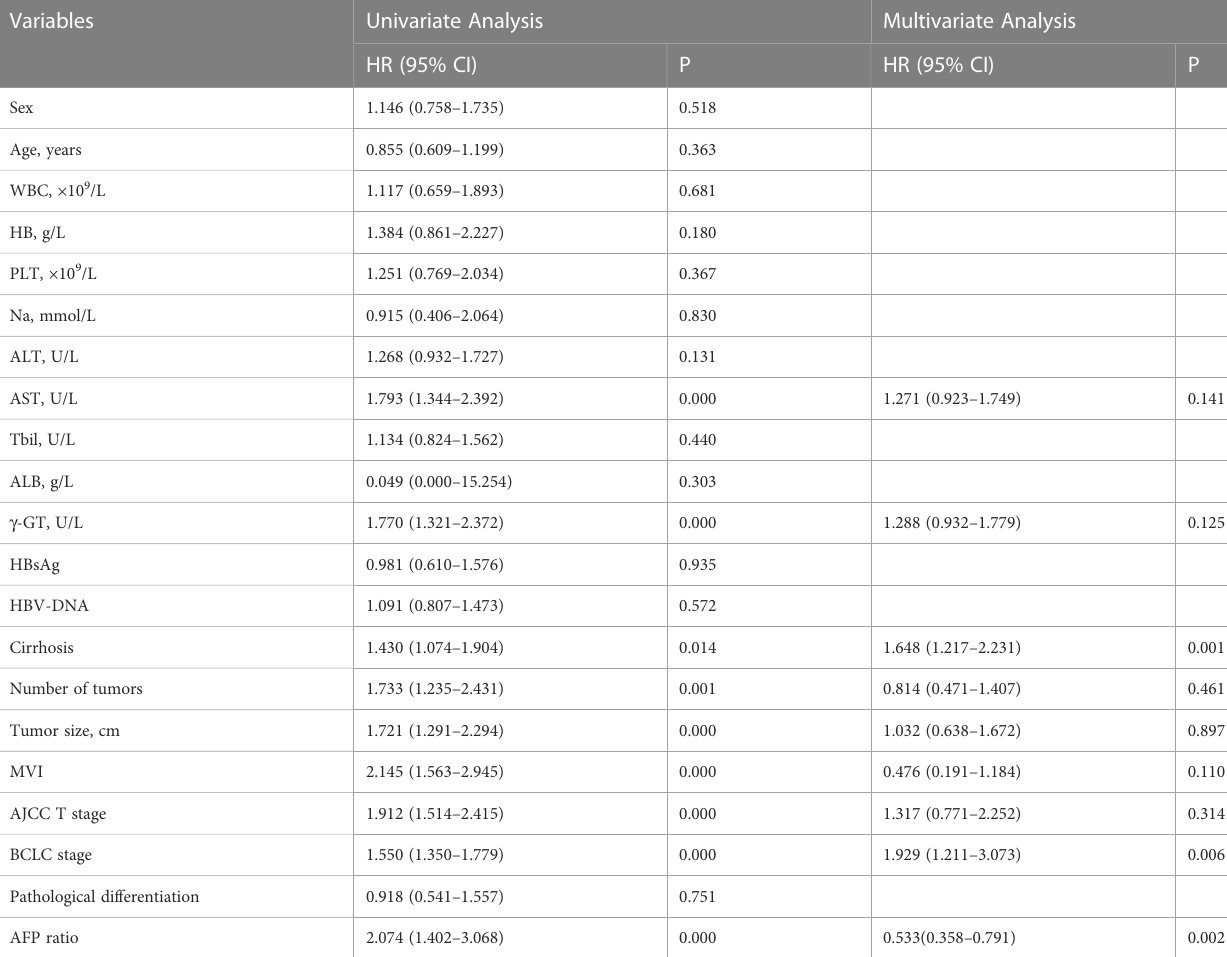
TABLE 3 Univariate and multivariate analyses for recurrence free survival in the training cohort. Variables Univariate Analysis Multivariate